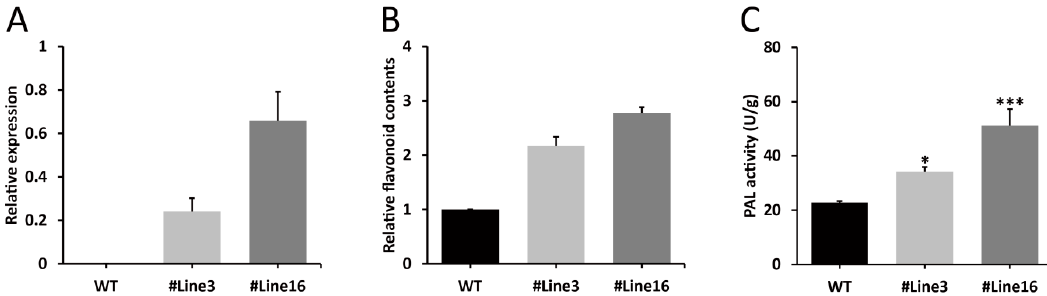
Figure 5. Transcriptional levels of LjaMYB12 , flavonoid contents and PAL activities in WT and transgenic Arabidopsis. ( A ). Transcriptional levels of LjaMYB12 in WT and transgenic Arabidopsis. ( B ). Flavonoid contents in WT and transgenic Arabidopsis. ( C ). PAL activities in WT and transgenic Arabidopsis. * and *** represent p < 0.05 and p < 0.001, respectively.